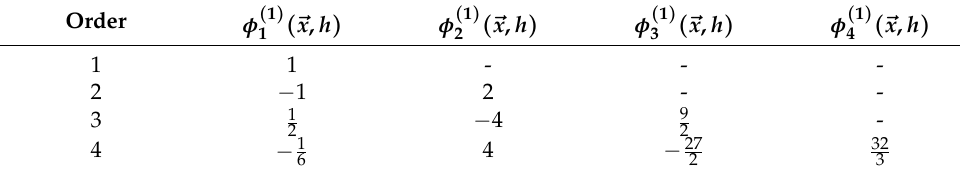
Table 1. Table of the weights for extended Richardson extrapolation up to order